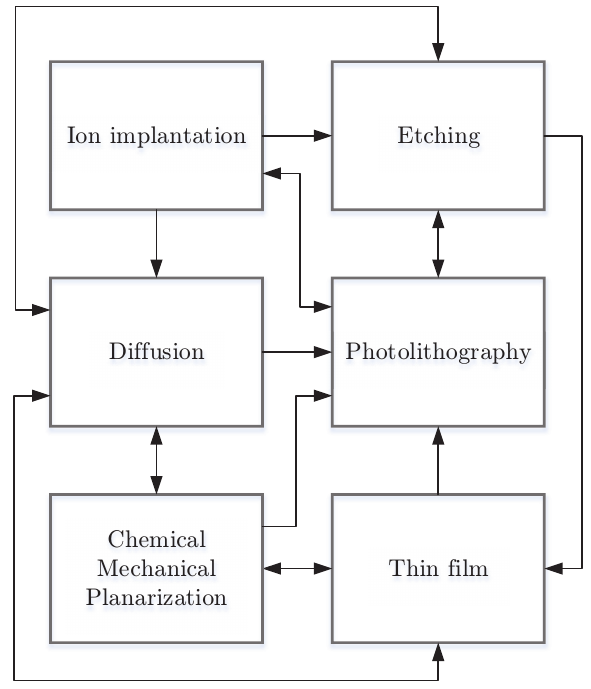
Figure 1. Abstract process flow of typical semiconductor